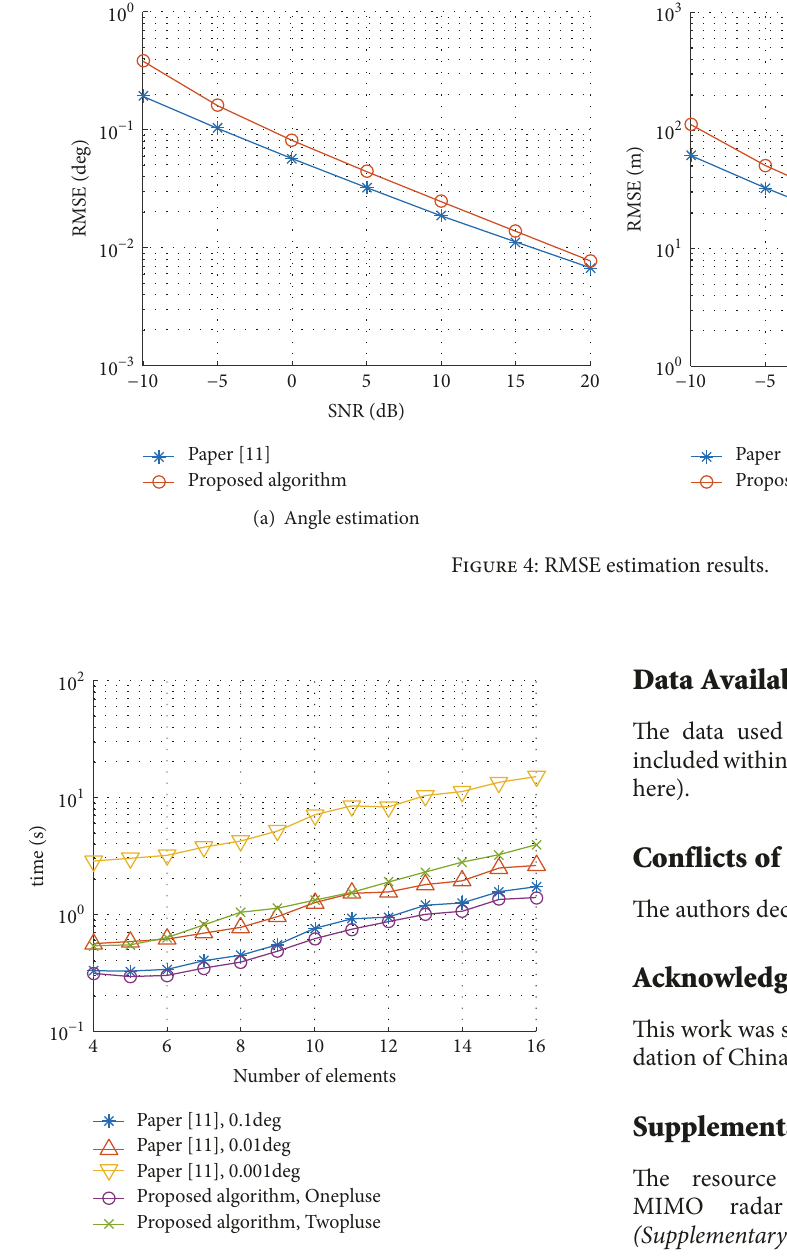
Figure 5: Comparison of computational